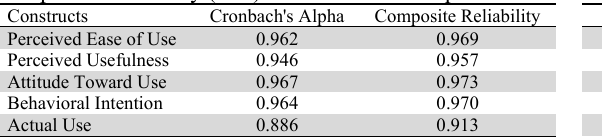
Composite Reliability (C.R) dan Cronbach’s Alpha Constructs